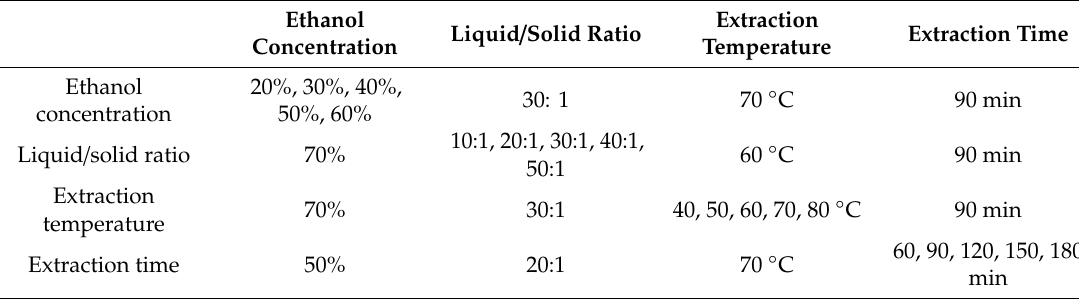
Table 8. The extraction conditions of single element